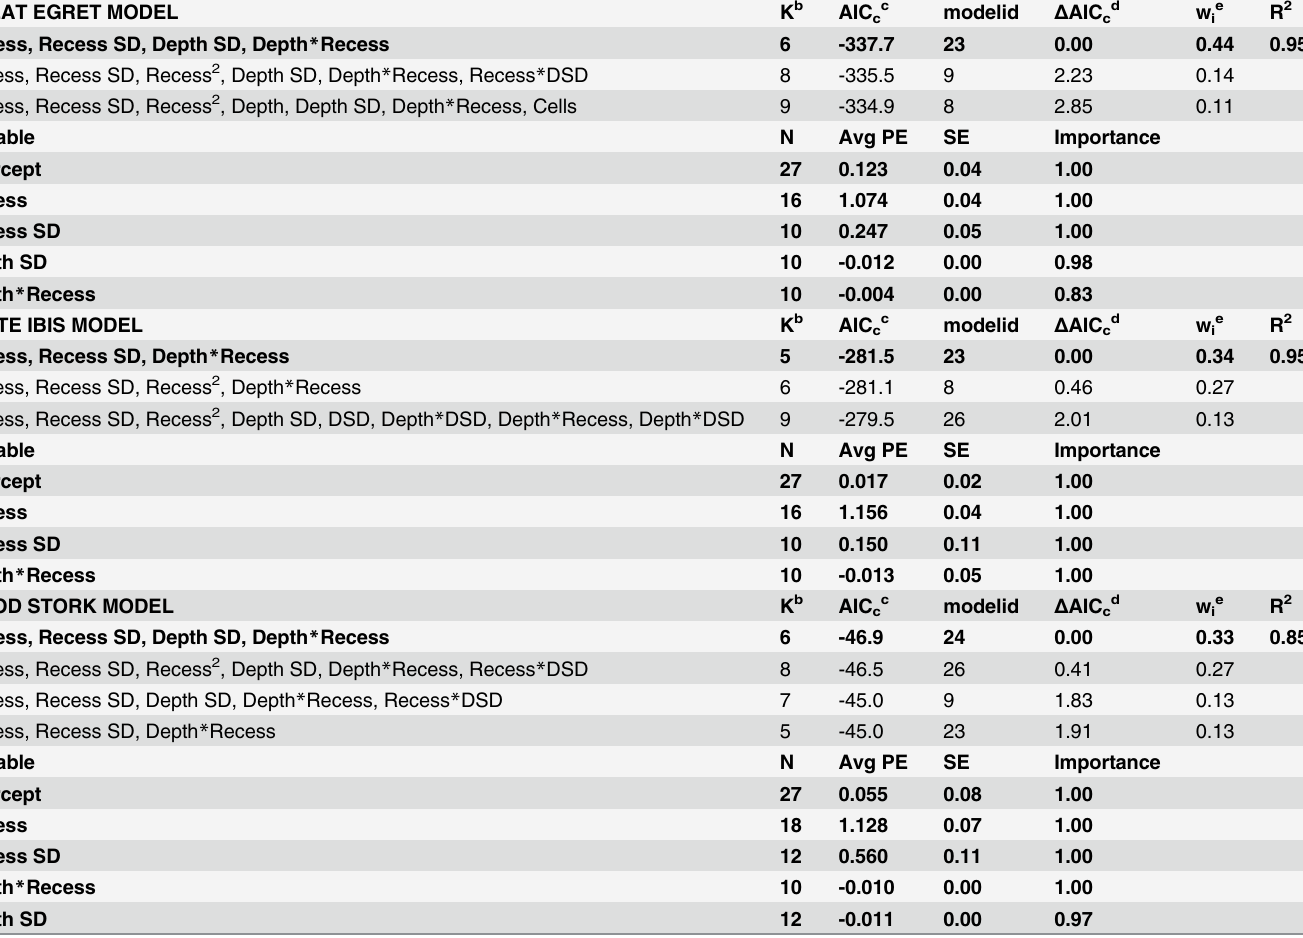
Table 2. Ranking of candidate models describing variables influencing daily mean 2-week recession rate use of Great Egrets, White Ibises, and Wood Storks in the Florida Everglades (Proc Mixed).